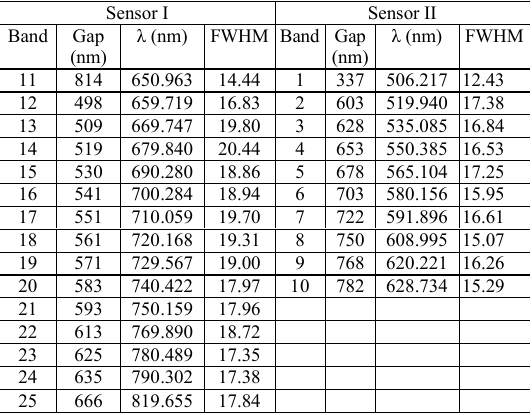
Table 2. Band numbers, air gaps of the FPI, full width of half maximum (FWHM) and wavelengths of the